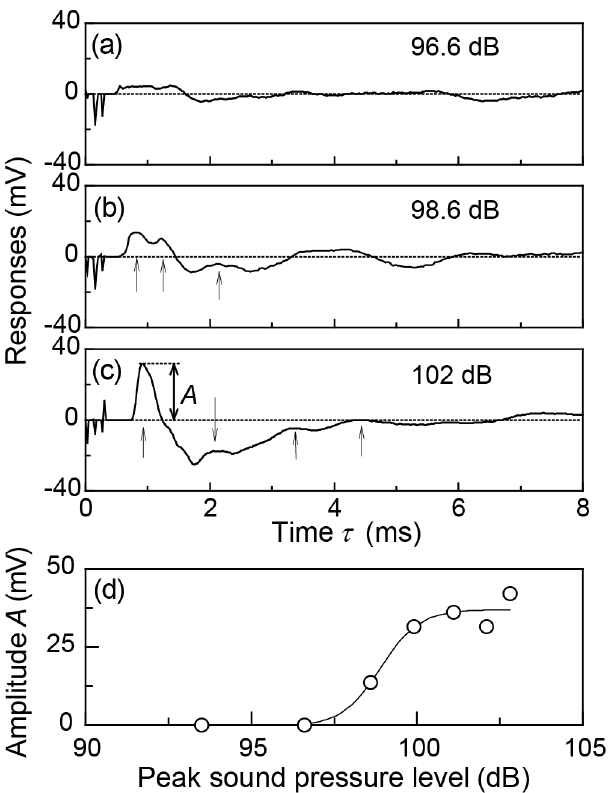
Fig. 6 eABR results by using Ch. 10 and 10 kHz pulsed acoustic wave at peak sound pressure levels of (a) 96.6, (b) 98.6, and (c) 102 dB, respectively. (d) Relationship between peak sound pressure levels and amplitude A of first